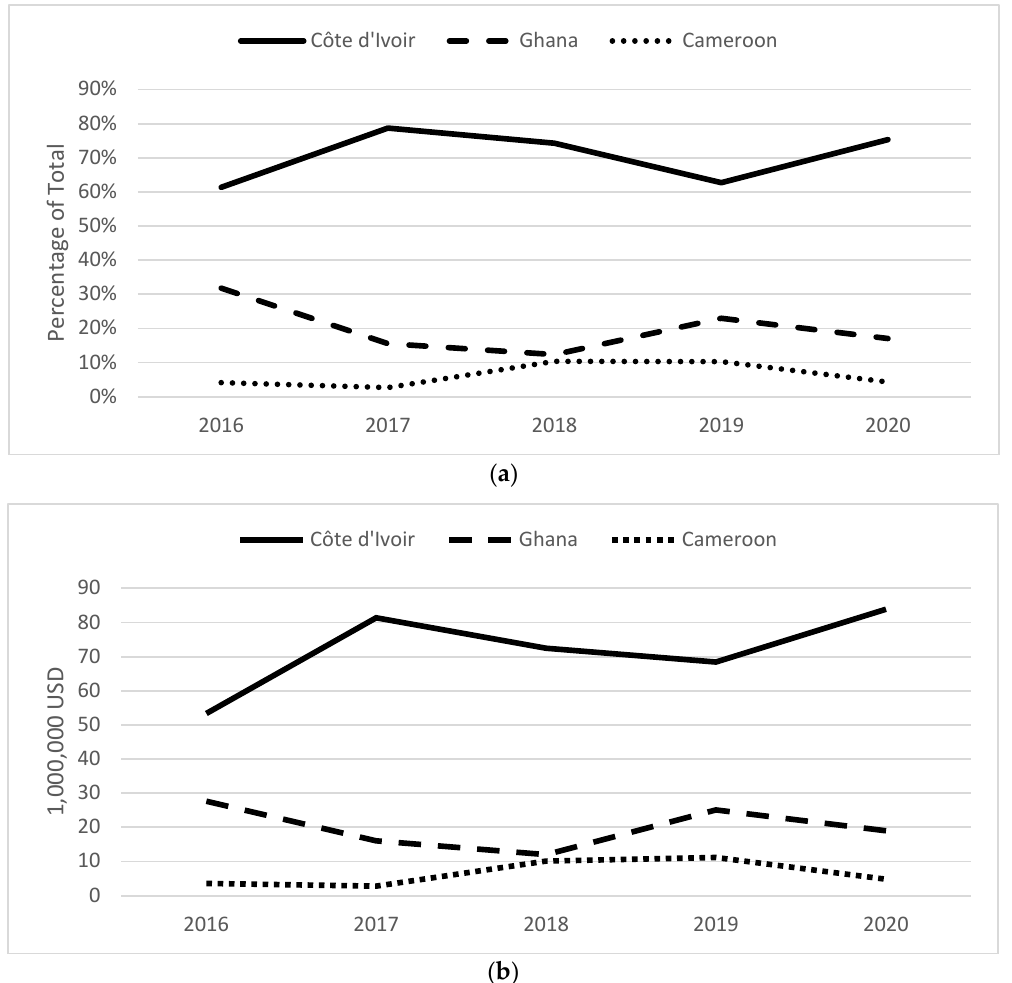
Table 1. Turkish Imports of Cocoa Beans (%) by Country of Origin.